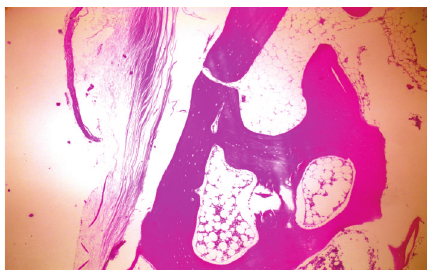
Figure 1: Preoperative radiographic evaluation with X-ray.